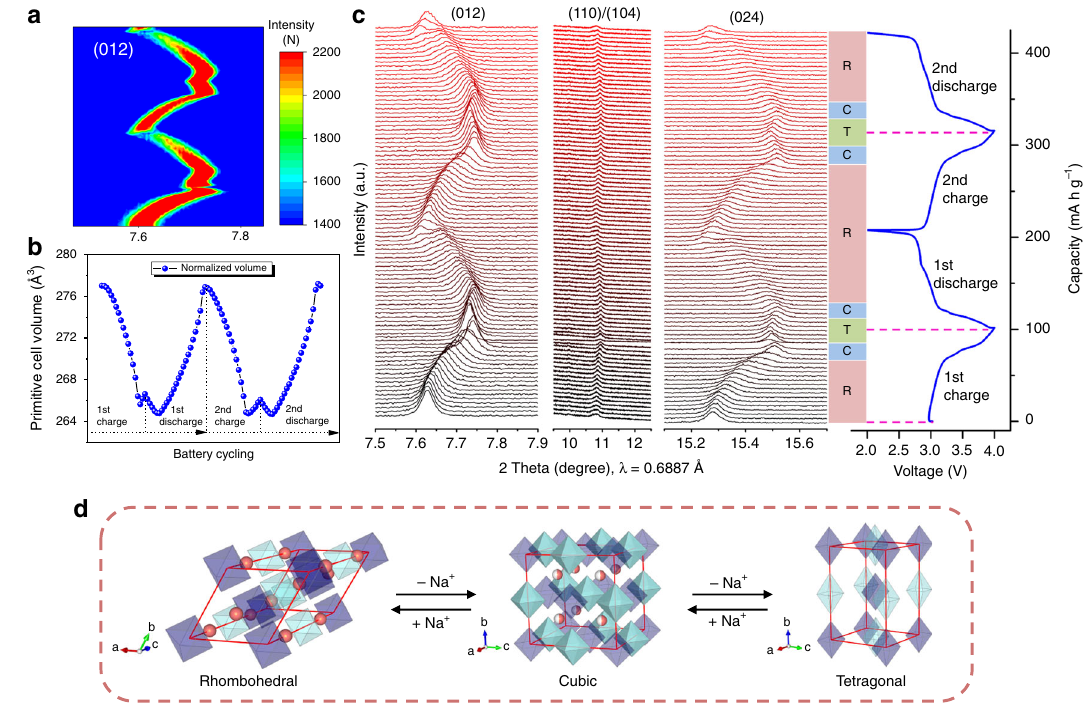
Fig. 4 Investigation of phase transitions of Na 1.73 Fe[Fe(CN) 6 ]·3.8H 2 O sample with rhombohedral structure during cycling. a 2D contour plot of (012) re fl ection plane, b normalized volume during charge – discharge process obtained from synchrotron in situ PXRD patterns of rhombohedral PB-S3, c (012), (110)/(104), and (024) re fl ection planes of synchrotron in situ PXRD patterns, d schematic three-phase evolutions during cycling of rhombohedral PB-S3.